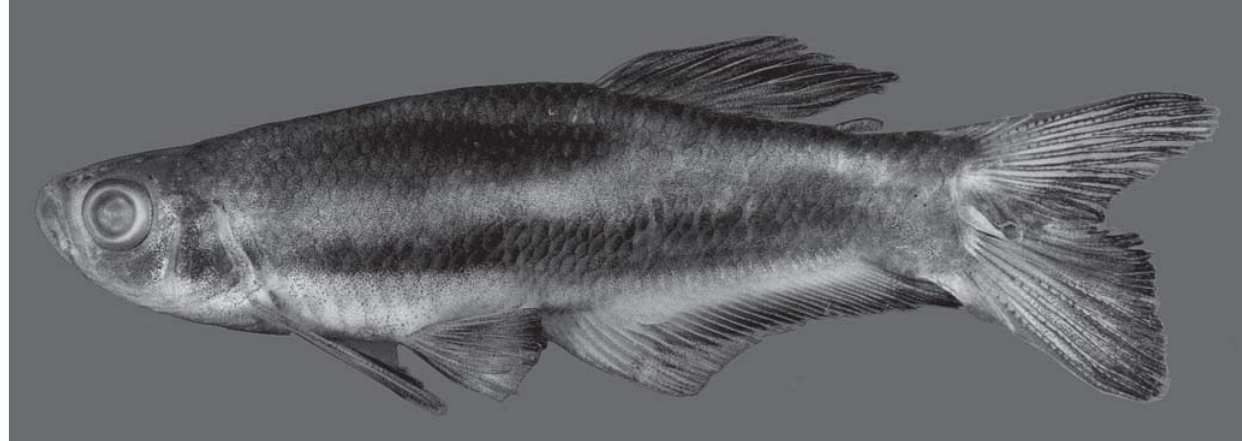
Fig. 53. Mimagoniates lateralis , live adult male, USNM 254268, 29.9 mm SL, Brazil, Paraná State, unnamed blackwater stream emptying into Atlantic Ocean about 5 km S of